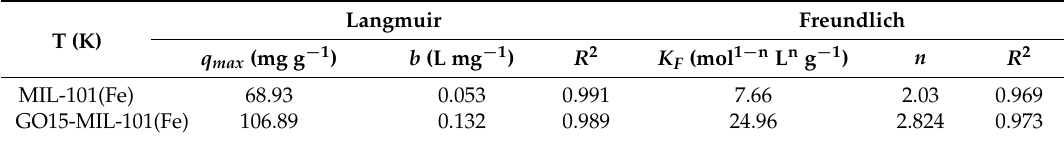
Table 2. The simulated adsorption isotherm parameters of U(VI) on MIL-101(Fe) and GO15-MIL-101(Fe) composites at 298 K.